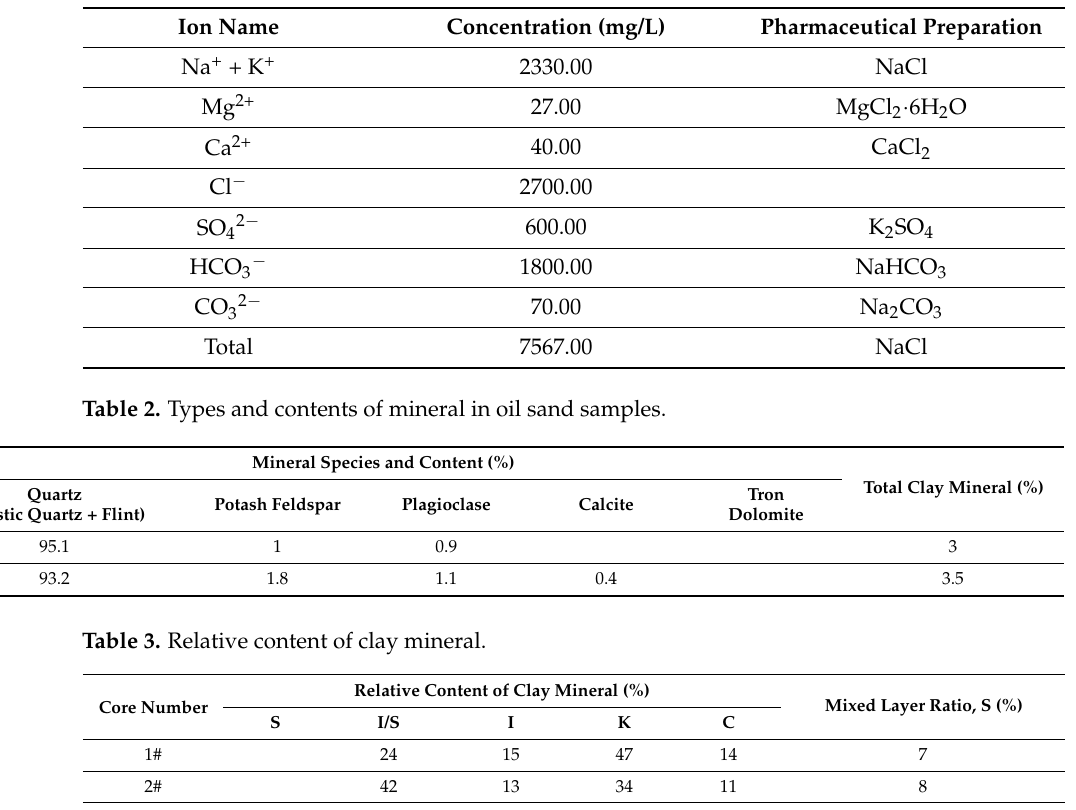
Table 1. Ionic and chemical composition of formation water.